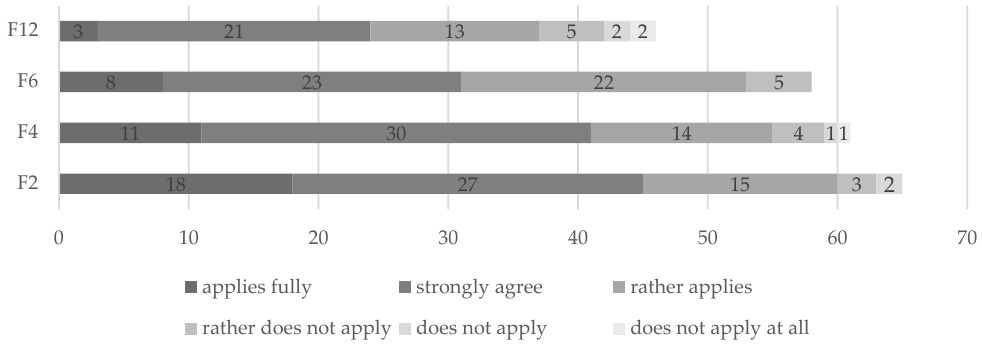
Figure 6. Long-term improvement of health knowledge due to “VIDEA bewegt”. Notes: Presentation in numbers of participants. Abbreviations: F2 = two months after the intervention, F4 = four months after the intervention, F6 = six months after the intervention, F12 = twelve months after the